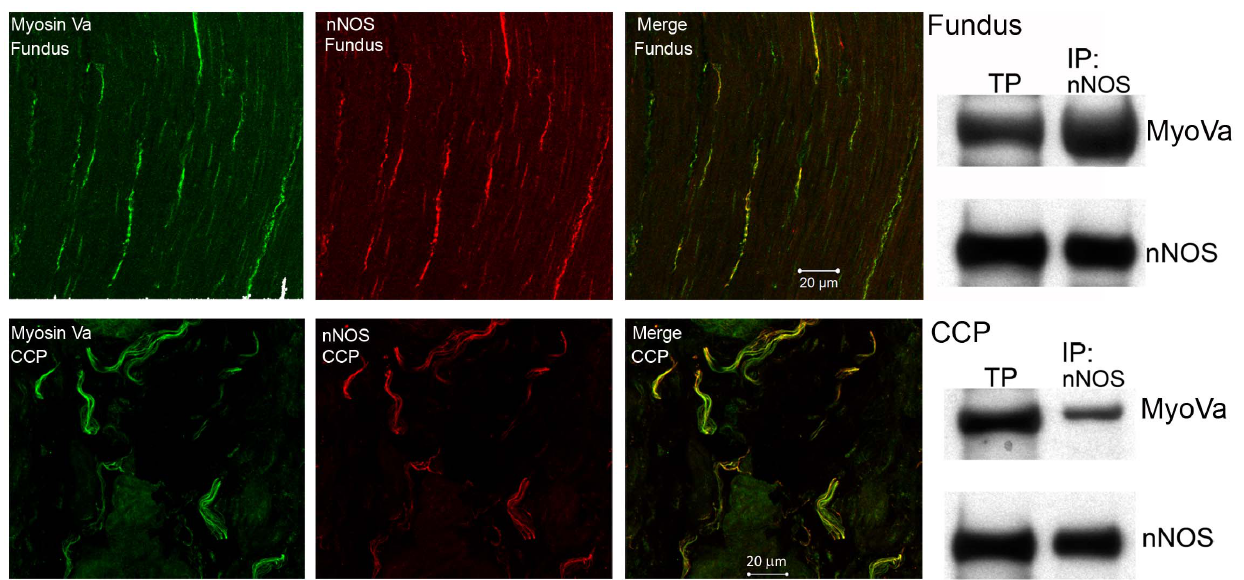
Figure 1. Localization and interaction of myosin Va and nNOS in the fundus and corpora cavernosa (CCP). In both fundus (top panels) and CCP (bottom panels), immunoreactivity for myosin Va (green) is present in nerve fibers that are immunoreactive for nNOS (red). Co-localization (yellow) is present in projected image. Western blot on right shows positive bands for myosin Va and nNOS in total protein lysate (TP) in lane 1. In lane 2, samples were immunoprecipitated for nNOS and blotted for myosin Va to demonstrate molecular interaction between these proteins in fundus (top panel) and CCP (bottom panel).